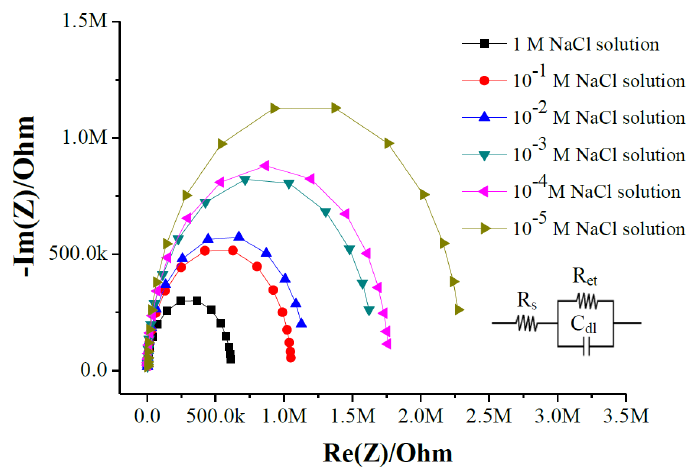
Figure 8. The electrochemical impedances of fitted curves at the different chloride ion concentrations. Table 3. The fitted results of R et , R s and C dl of the arrayed flexible RuO 2 /GO chloride sensor at different NaCl concentrations solution from 1 × 10 − 5 M to 1